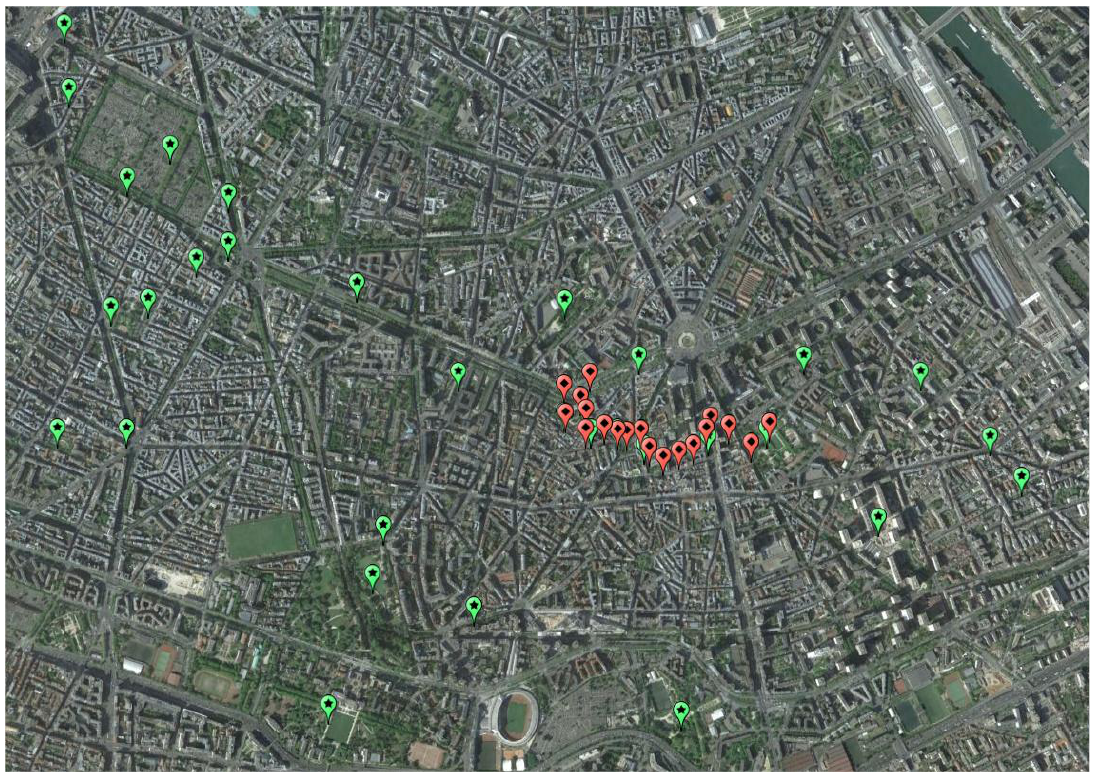
Figure 1: Locations of the evaluated situations. The red dots correspond to the 19 locations assessed in March 2015. The green dots corre- spond to the 29 locations evaluated at different moments of the day (35 different situations) between September 2013 and February 2014 (winter period), and correspond also to the same 35 situations assessed between March 2014 and September 2014 (summer